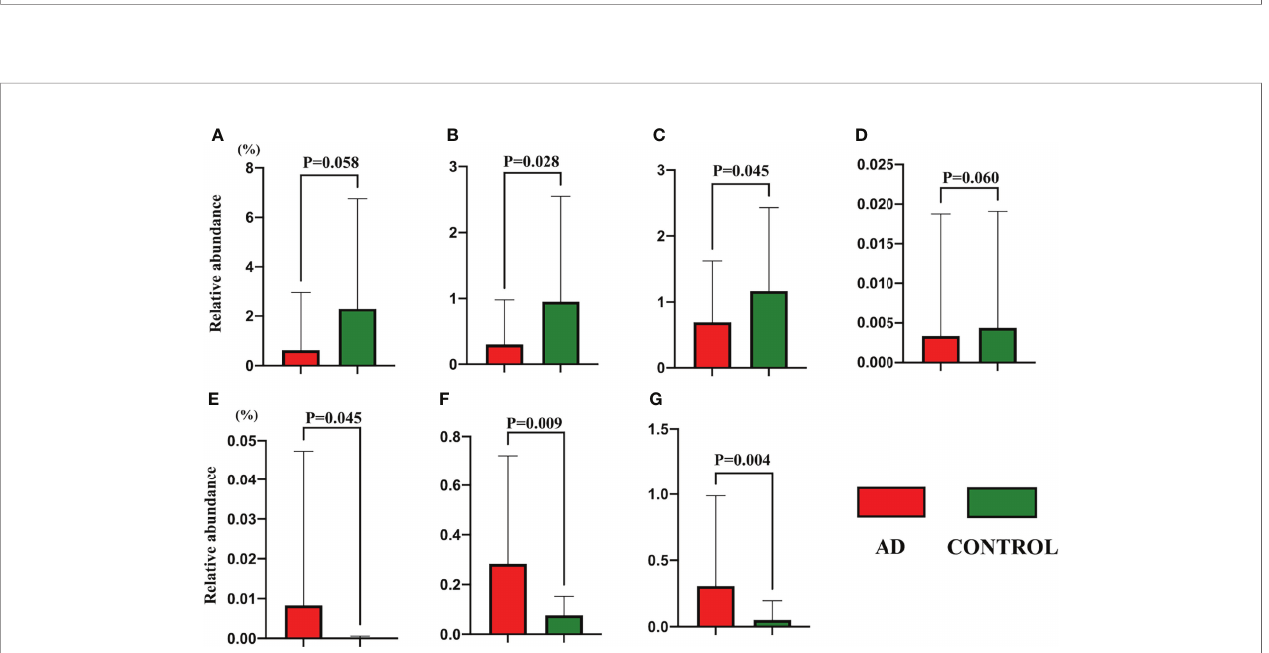
FIGURE 2 | The relative abundance of gut species detected in the LEfSe analysis between autistic children with and without atopic dermatitis. (A) Akkermansia muciniphila ; (B) Roseburia intestinalis ; (C) Haemophilus parain fl uenzae ; (D) Rothia mucilaginosa ; (E) Anaerostipes caccae ; (F) Eubacterium hallii ; (G) Bi fi dobacterium bi fi dum . Data are shown in mean and standard deviation, and the Mann – Whitney U test was